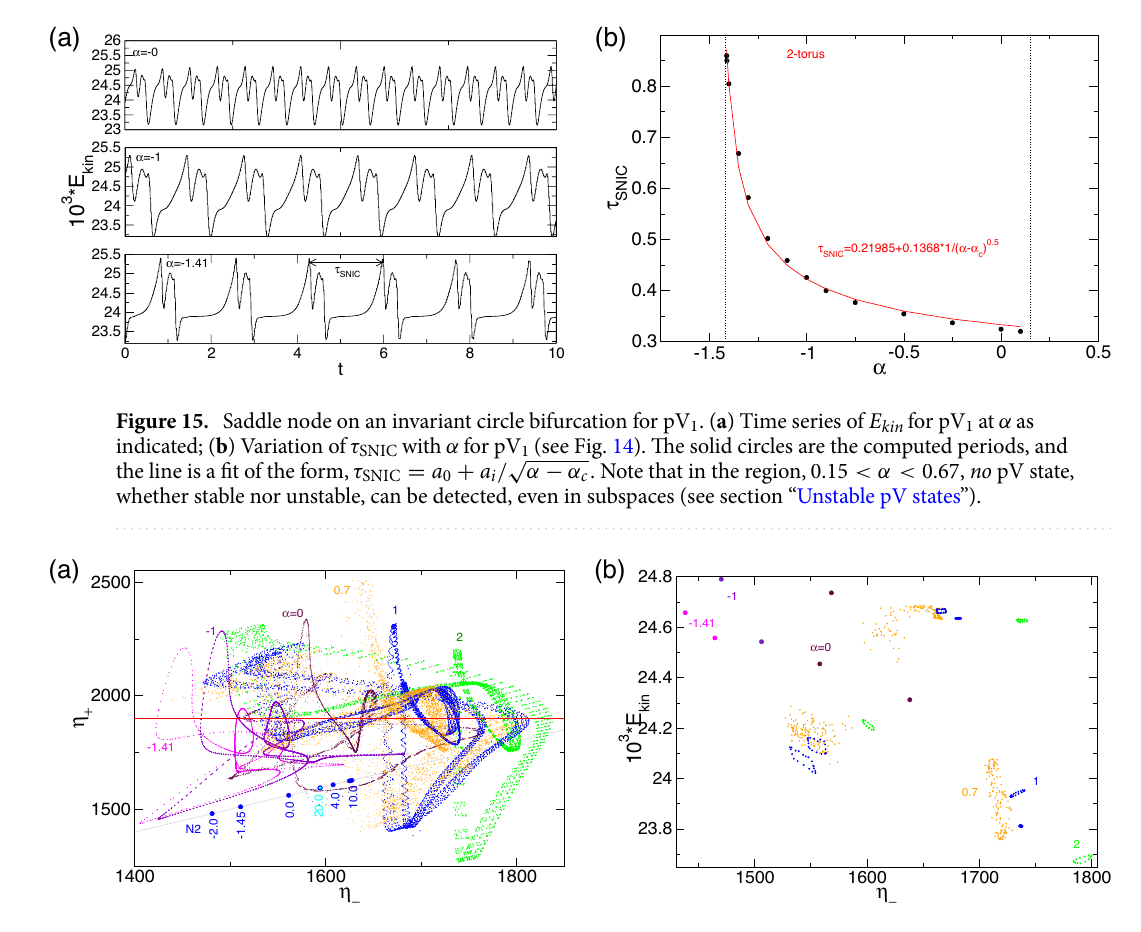
) and ( b ) the , η − + ) , with η 1900 (horizontal red line in ( a )). + = − η , upon − = +